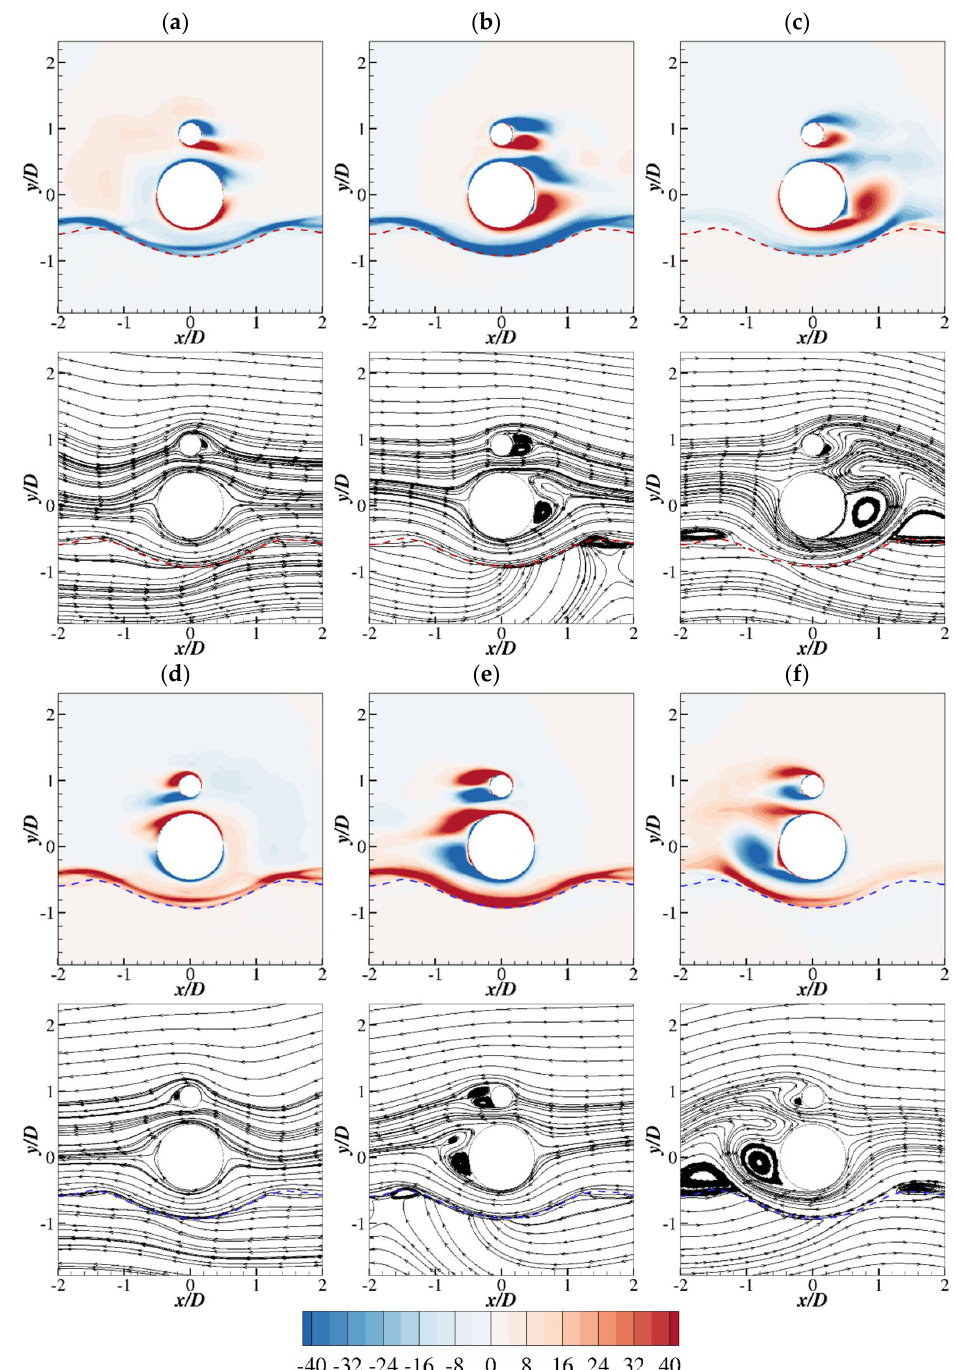
Figure 12. The phase-averaged spanwise vorticity and the streamlines for the piggyback pipeline with α = 90 ◦ at the phase of ( a ) T w /6; ( b ) T w /3; ( c ) T w /2; ( d ) 4 T w /3; ( e ) 5 T w /6; ( f ) T w . The dashed lines denote the iso-surface identified by φ =